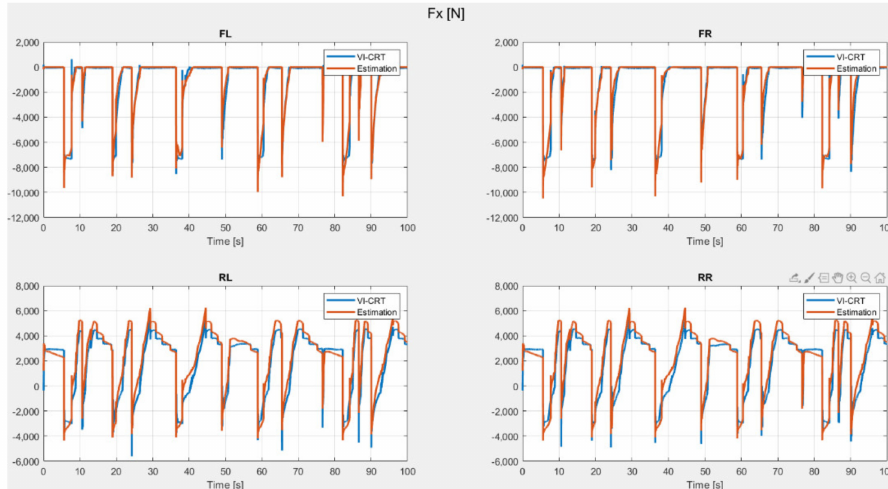
Figure 5. Longitudinal force (Fx) developed by each